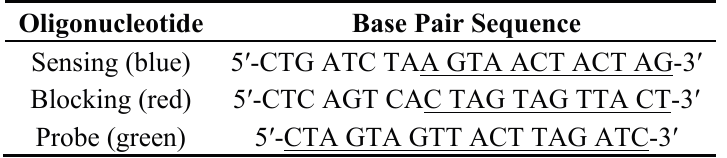
Table 1. Sequence of oligonucleotides used for double-stranded (dsDNA) supported junctions in the DNA- g -AAm hydrogels with an altered pore size distribution. The oligonucleotide base pair (bp) sequence is depicted for the sensing (S, blue in Figure 1) and blocking (B, red in Figure 1) oligonucleotides of the dsDNA-supported junctions and probe oligonucleotide (P, green in Figure 1) used for assessing the hydrogel swelling response. The underlined parts of the bp sequences denote the complementary